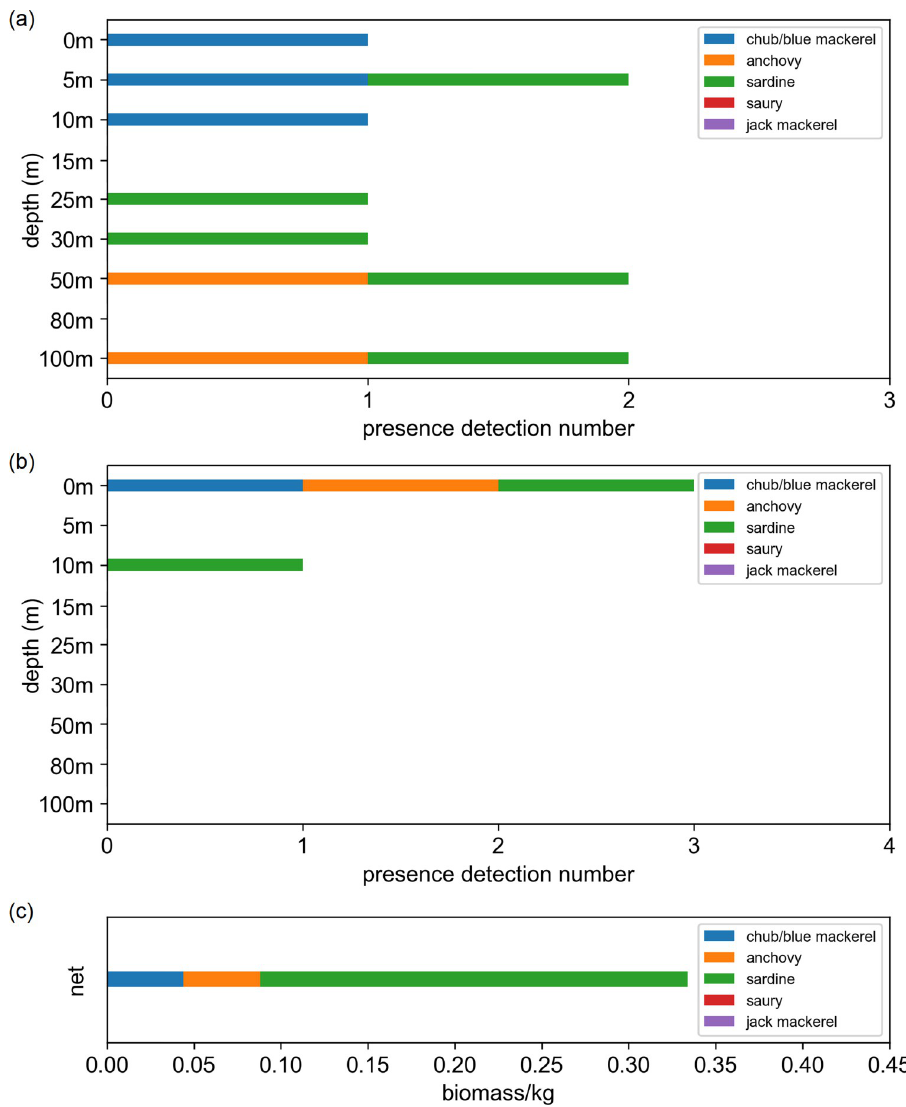
Fig 2. OceanDNA detection results of five target fish at station B06 and fish caught in net sampling. Detection results using (a) qPCR method and (b) MiFish method, and (c) fish biomass data from the net sampling (pelagic trawling, at depth of 0–25